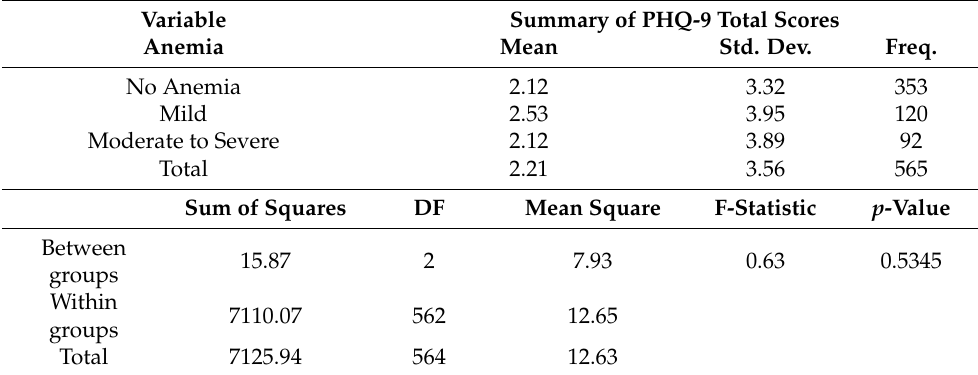
Table 2. Chi-Square Test for Trend (One-Way ANOVA).